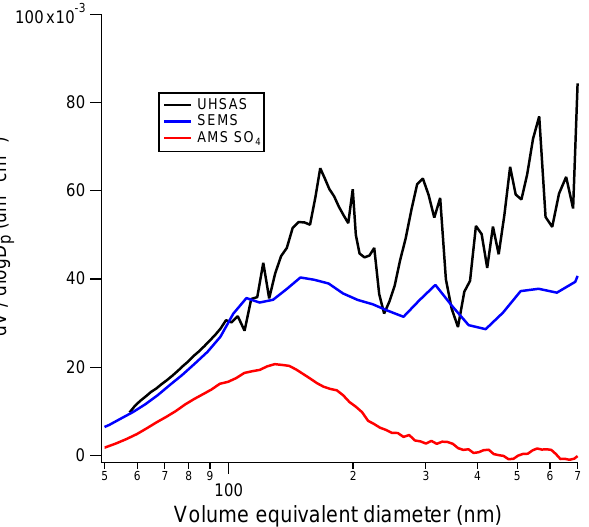
Figure 2. AMS PToF results of AMS sulfate for 2014 as functions of wind speed (solid lines (>8ms − 1 ) vs. dotted lines (2–8ms − 1 and <2ms − 1 )) and wind direction (black (northwest) vs. red (east– southeast)). The PToF mass has been arbitrarily scaled to enhance readability of the figure. The PToF results for 2015 are identical in both distribution shape and peak location for all wind regimes.